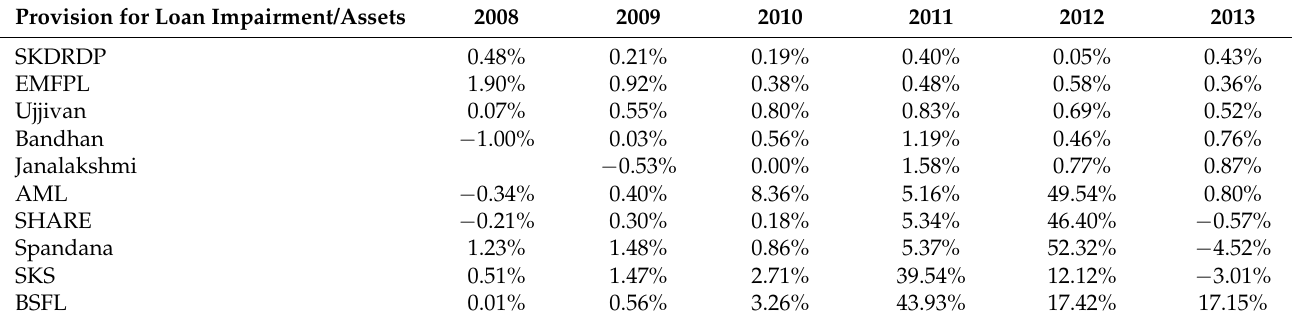
Table A3. Provision for Loan Impairment of Top Indian MFIs.